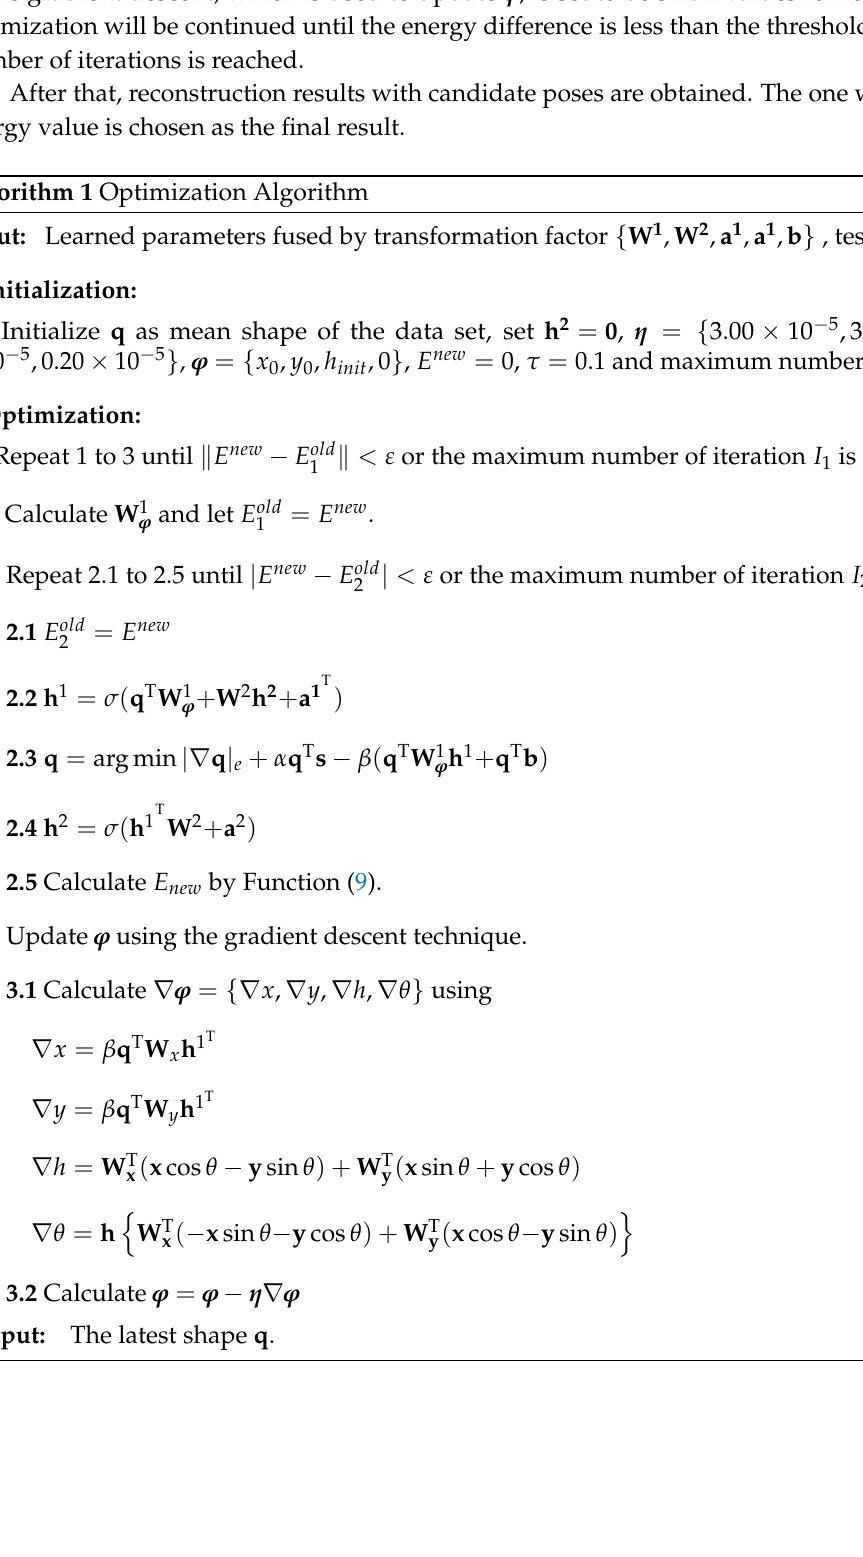
Algorithm 2 is the details of Split Bregman method to solve the problem of minimizing q in Algorithm 1 step 2.3.